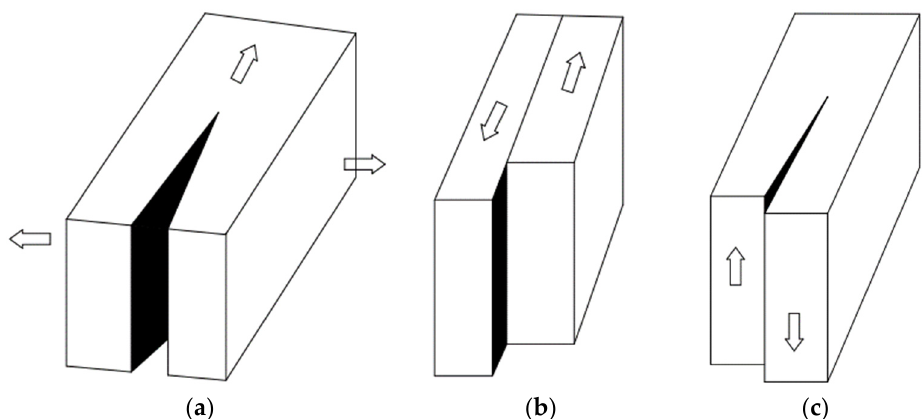
Figure 18. Crack opening modes: Mode I or opening/tensile-mode cracks ( a ), Mode II or sliding/in- plane shear ( b ), and Mode III or tearing/out-of-plane shear ( c ) [147].